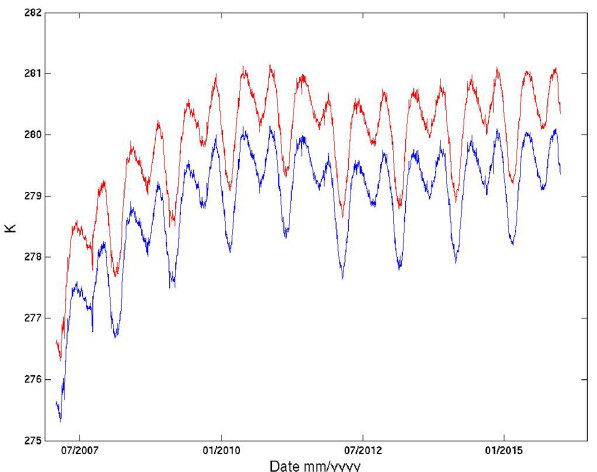
Figure 11. Instrument optical bench temperature sampled once per day in the coldest part of the orbit during solar calibration measure- ments (blue line) and the maximum temperature encountered during the orbit (red line). The orbital variation (distance between blue and red lines) is about 1K. All remaining variation is the result of sea- sonal and long-term changes in platform and therefore instrument